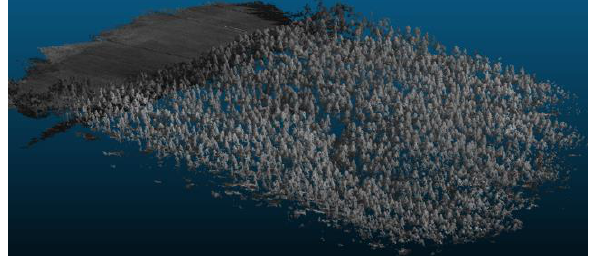
Figure 7. DSM of a forest area created with SURE, 10cm point